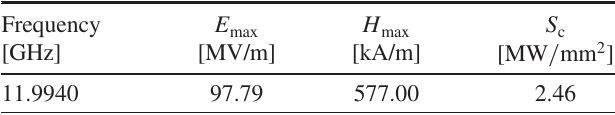
TABLE V. Rf parameters of the storage